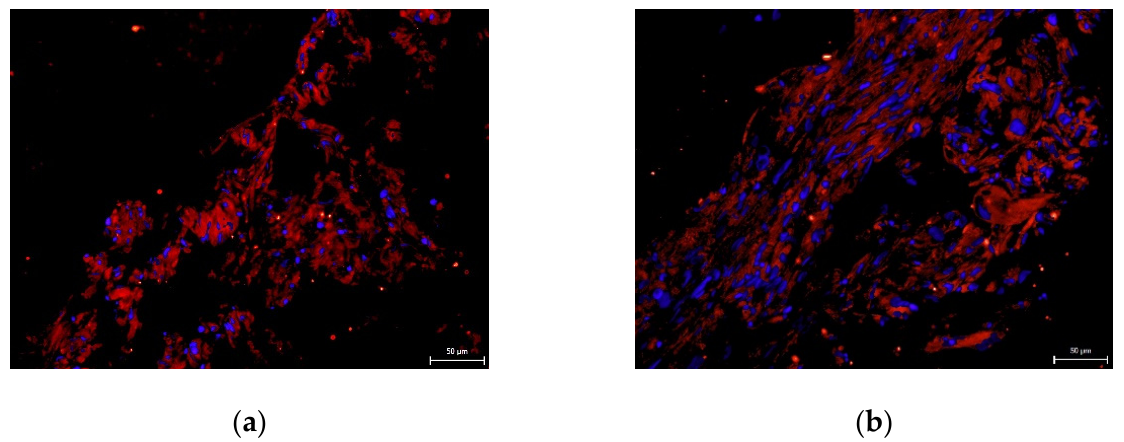
Figure 7. Immunocytochemical visualization of type II collagen in an extracellular matrix of paired DPSC lineages after chondrogenesis. Type II collagen shows up as fluorescent red, and stem cell nuclei fluorescent blue. Scale bar 50 µ m. ( a ) Lineage 5-A; ( b ) Lineage 5-B.